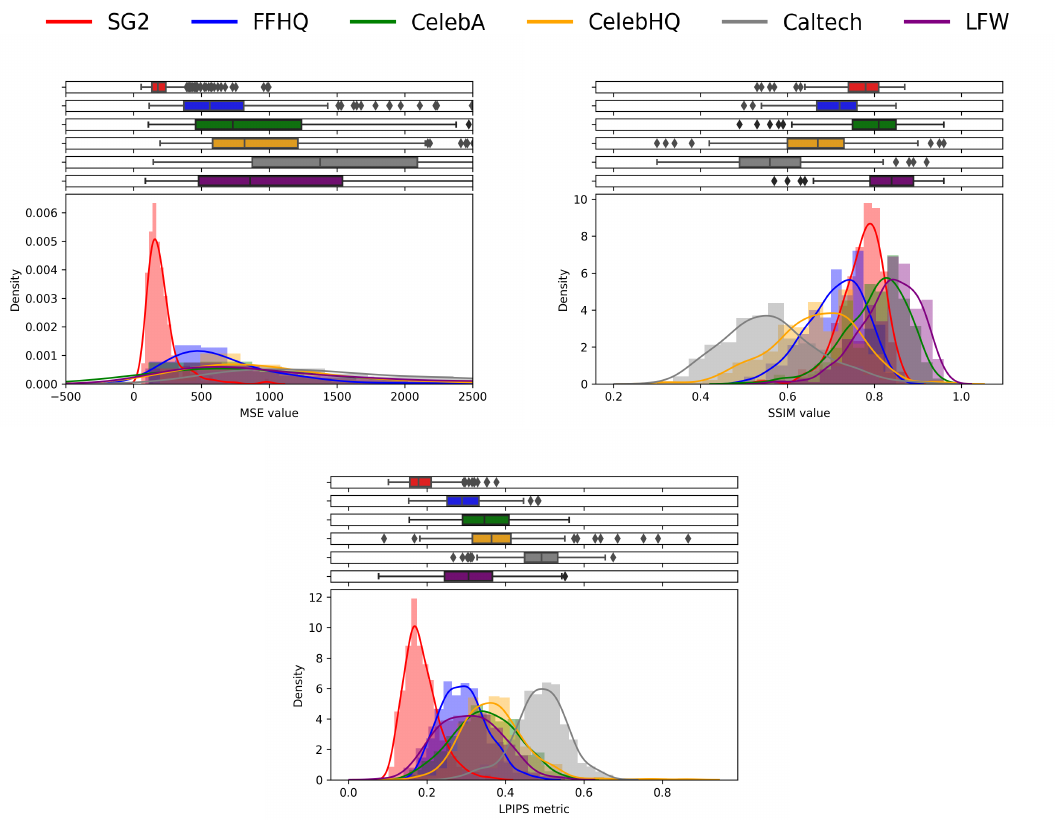
Figure 7. Histograms of different similarity metrics for images belonging to different datasets and their reconstructed counterparts. For each case, we report the density of the values of each similarity metric and their https://seaborn.pydata.org/generated/seaborn.boxplot.html (accessed on 30 December 2022) on top of the histogram, highlighting the interval between the first and third quartiles of each dataset (colored box), the median value of the distribution (vertical line within the colored box), and the outliers (grey